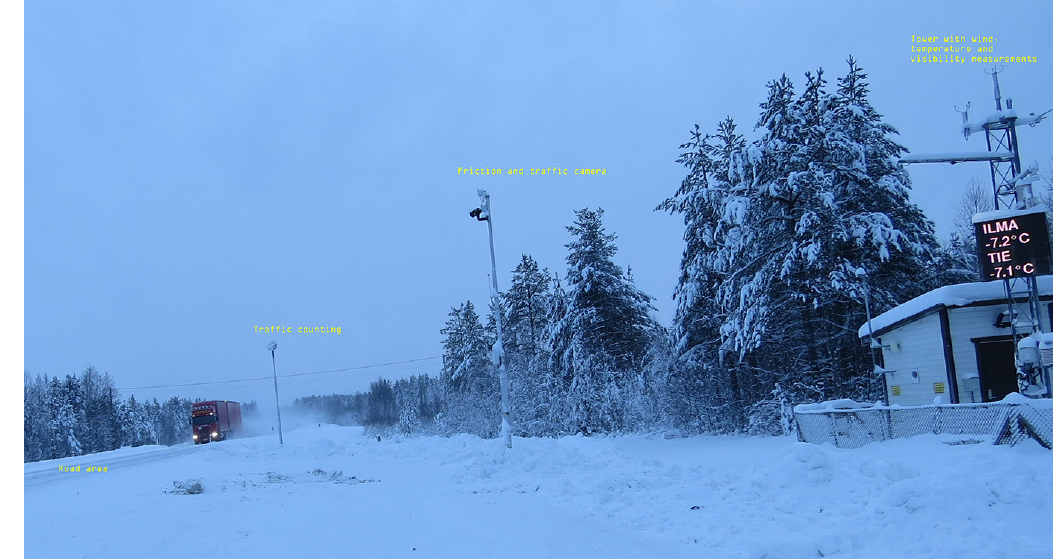
Figure 1. Combined RWS–RSU